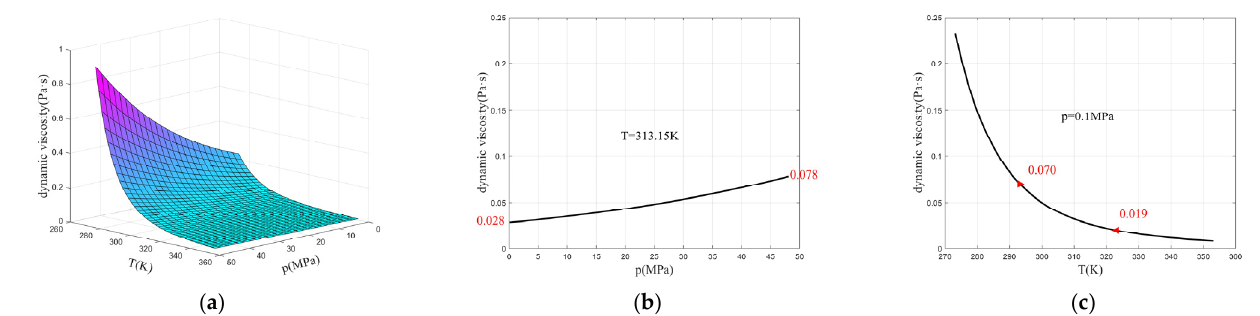
Figure 6. ( a )Viscosity–pressure and viscosity–temperature relationship; ( b ) viscosity–pressure relationship at T = 313.15 K; ( c ) and viscosity–temperature relationship at p = 0.1 MPa.